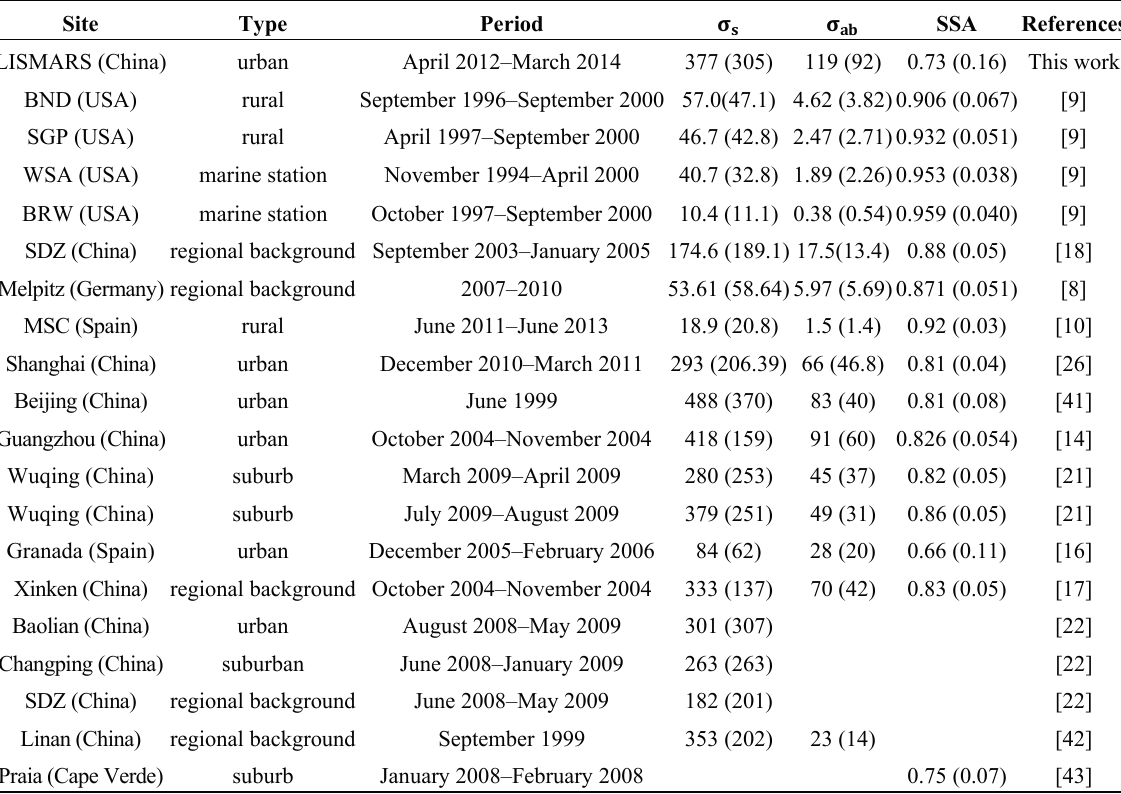
Standard deviation values are stated within the